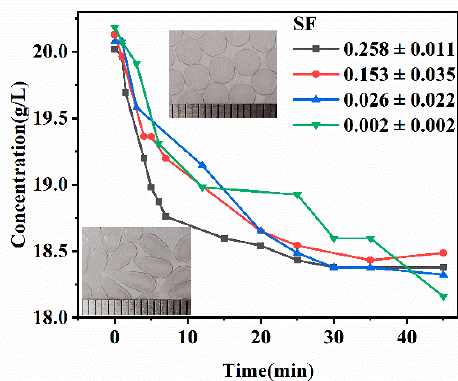
Figure 11. The effect of SF on the permeability of mm-CaSA-Caps. The concentrations of CMC were 0.75 ( SF = 0.258 ± 0.011), 1.0 ( SF = 0.153 ± 0.035), 1.25 ( SF = 0.026 ± 0.022) and 1.5 ( SF = 0.002 ± 0.002) wt.%. The concentration of SA was 0.75 wt.%. The concentration of CaCl 2 was 1.5 wt.%.